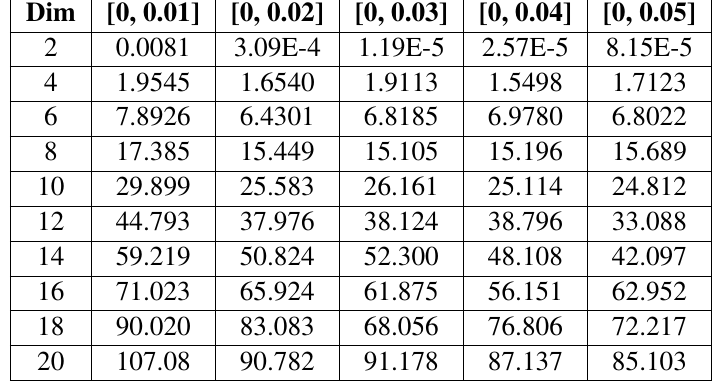
Table 4: Results on Rastrigin function from 2 dimensions to 20 dimensions